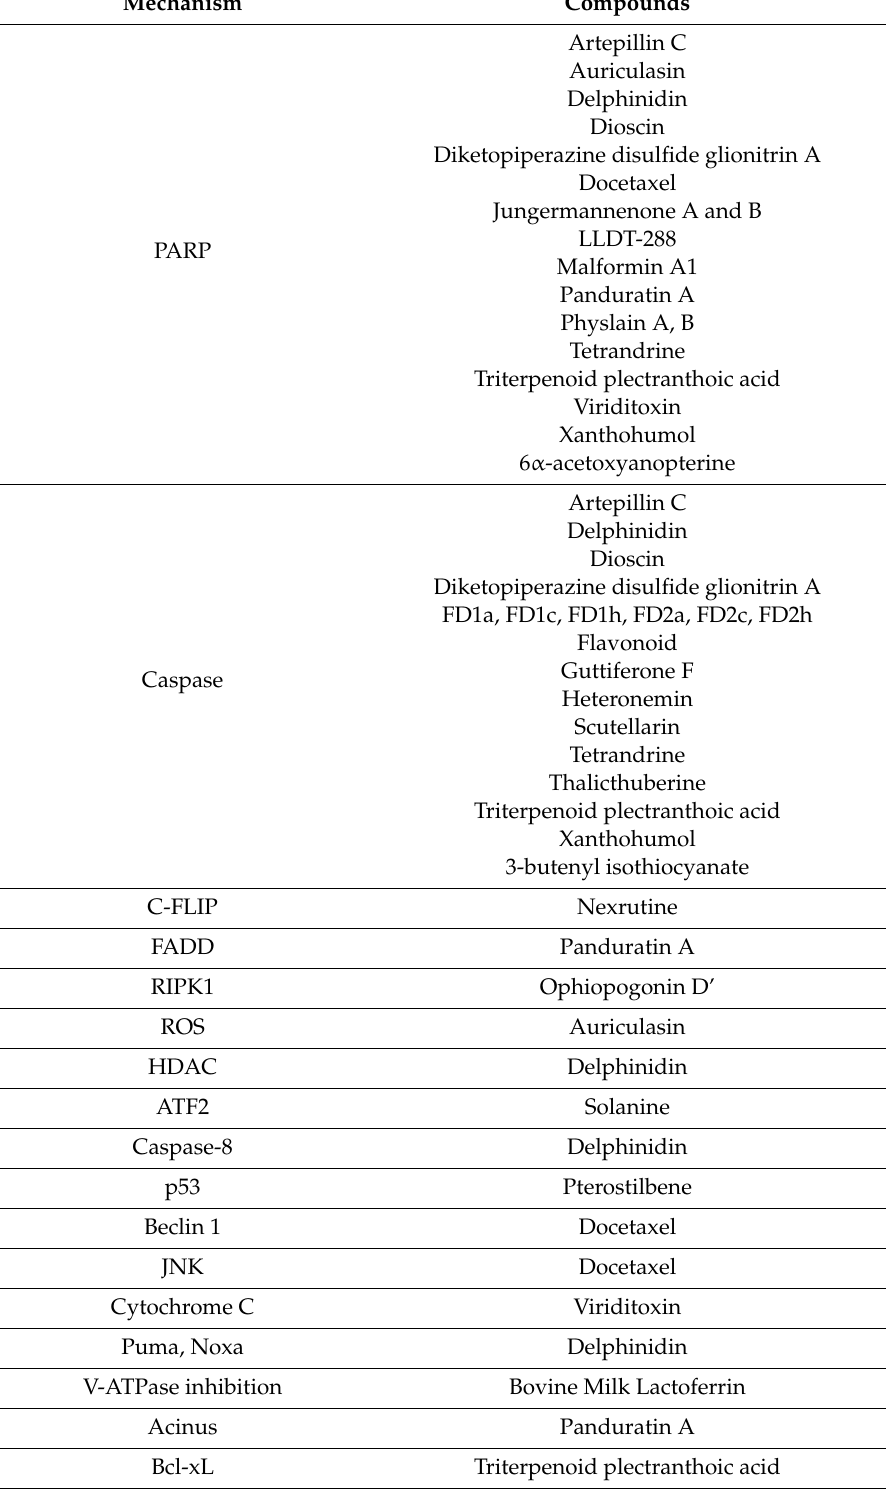
Table 4. Dietary products regulating main apoptosis signal